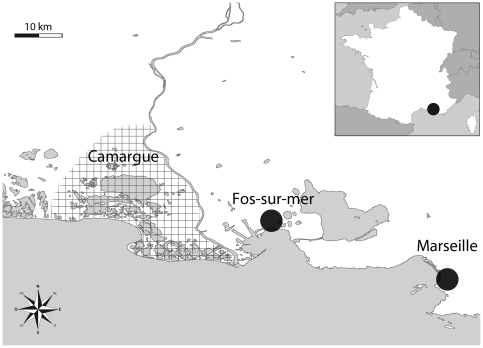
Location of the study sites.The city of Marseille and the town of Fos-sur-mer are indicated by circles, and the Camargue area is cross-hatched.